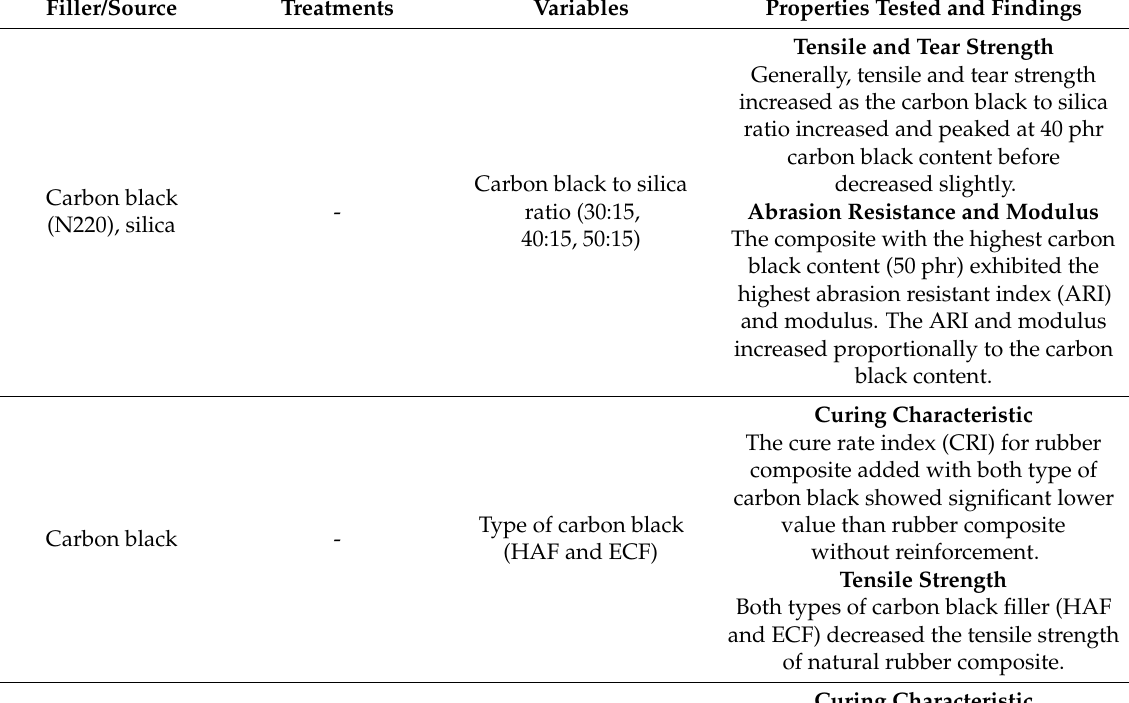
Table 1. The summary of literature using carbon black as the main filler for natural rubber composite.